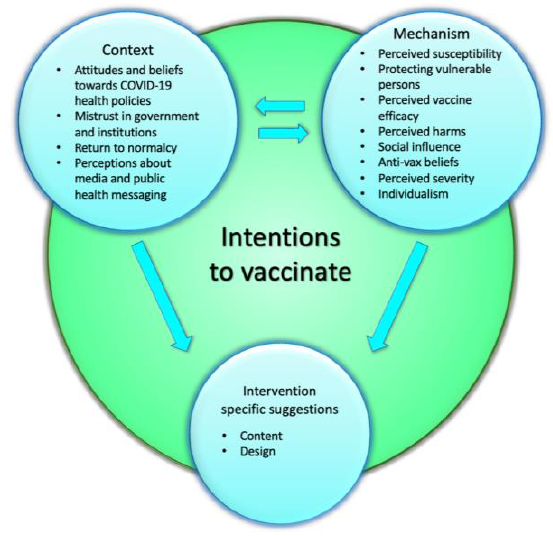
Figure 1. CMO Thematic Structure.